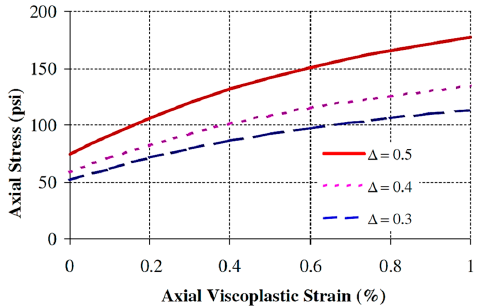
Figure 12. Effect of anisotropy on the stress–strain relationship predicted by the model. Reprinted with permission from [ 87 ] . 2005, International Journal of Plasticity, Elsevier.